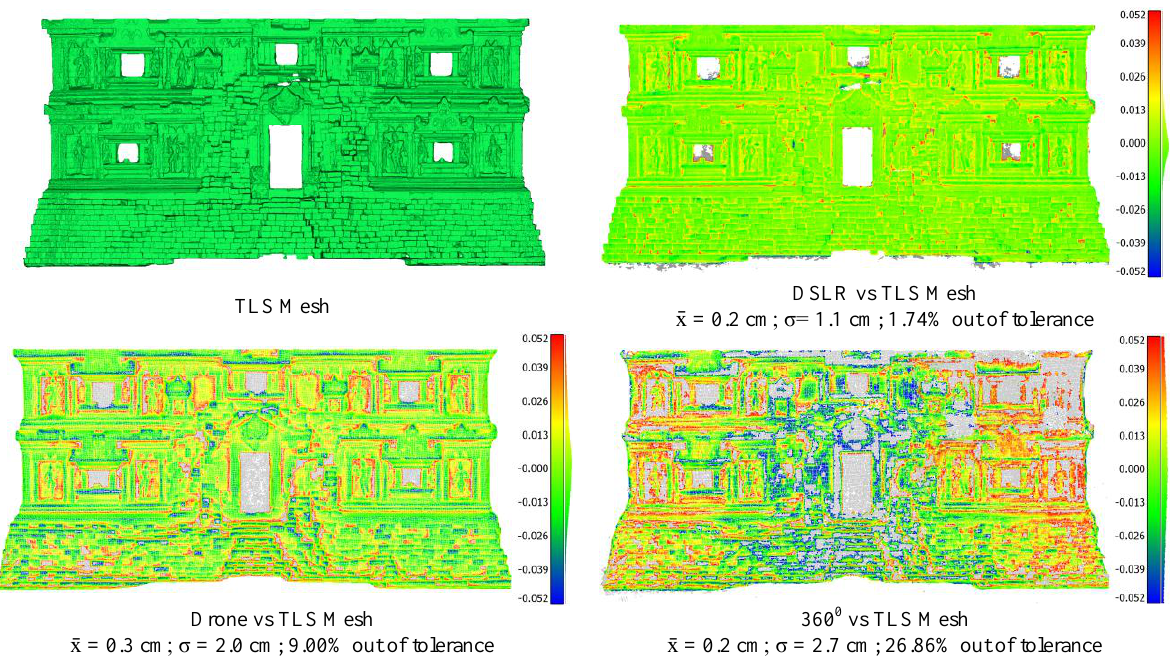
Figure 3. Euclidean distance analysis between the reference (meshed model from TLS point cloud) and the dense point cloud generated from each data set. x denotes mean deviation from the reference and σ the standard deviation. Grey points are points outside the determined